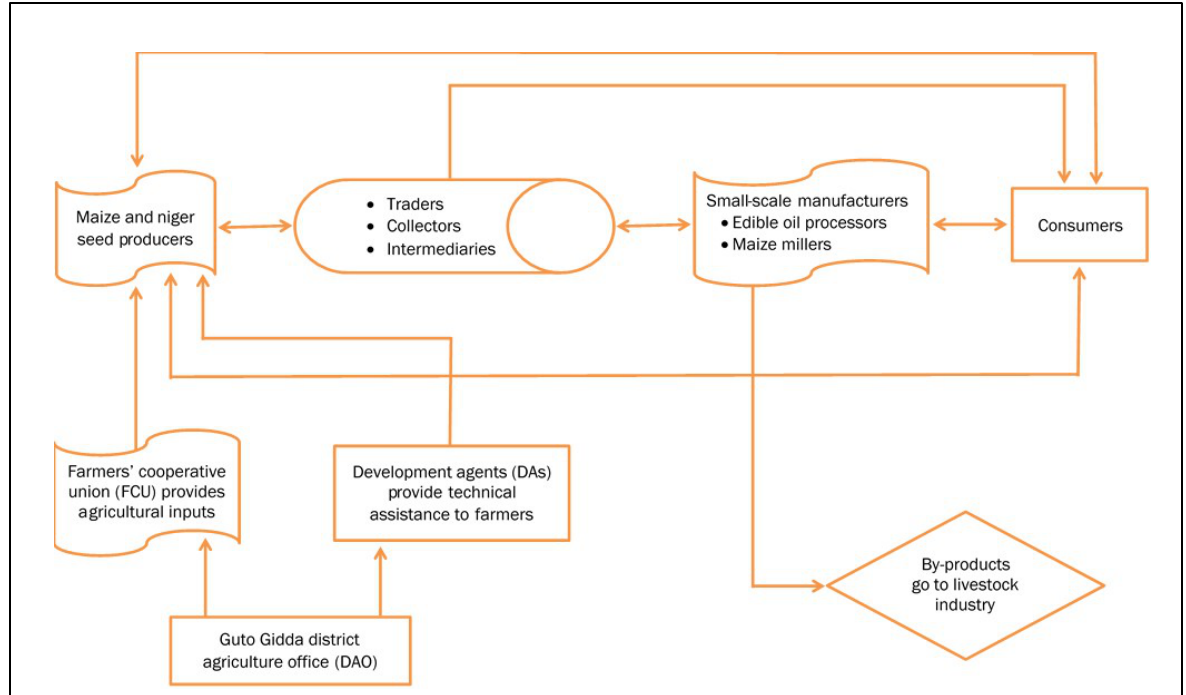
Figure 2. Maize and Niger Seed Value Chain Diagram in Guto Gidda